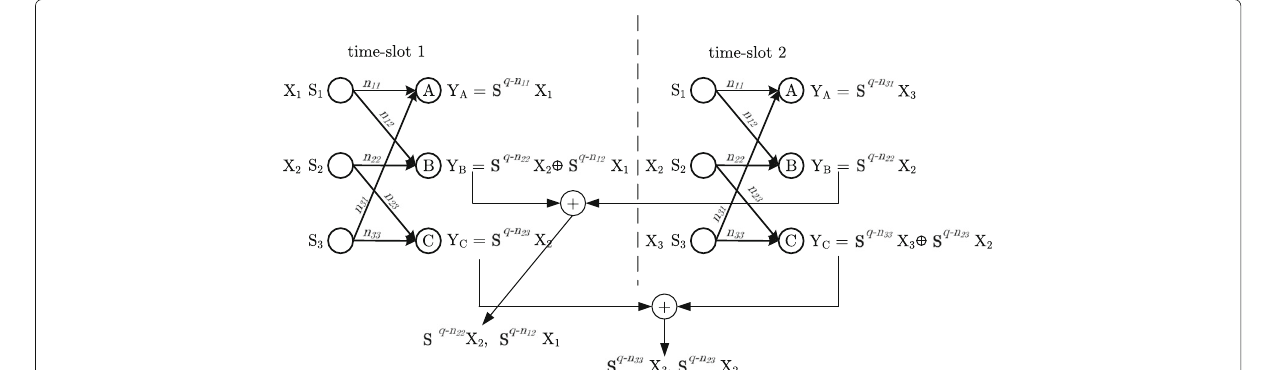
Fig. 5 Achievability strategy for the first layer of the network in Fig. 4a